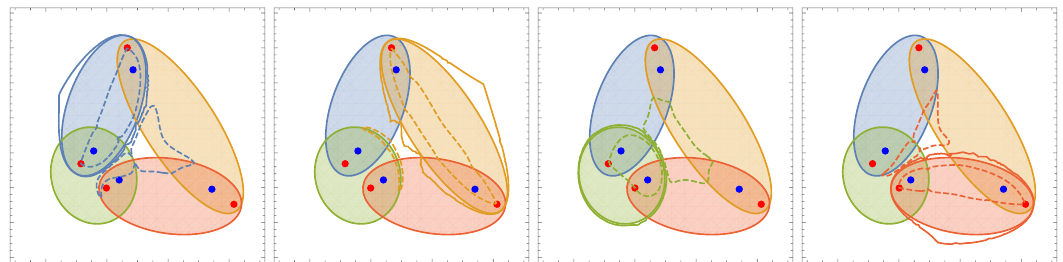
Figure 8. Surface structure in integration momentum space before and after deformation: for each existing E-surface (cid:17) of the Box4E , we show the solutions to (cid:17) = 0 without contour deformation, i.e. ~(cid:20) = ~ 0, as ellipses with shaded interiors. With a contour deformation enabled, the zeros of the real part of the complex E-surface Re (cid:17) = 0 are shown as solid lines, where the zeros of the imaginary part Im (cid:17) = 0 are dashed. Note that on the integration contour, each E-surface develops one surface where Re (cid:17) = 0 and two separated surfaces where Im (cid:17) = 0. Additionally, on each focal point (red) it holds that Im (cid:17) = 0, which is not apparent in this plot.